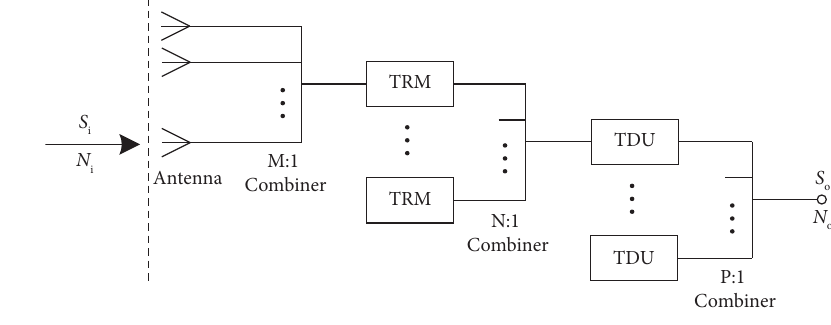
Figure 2: Block diagram of an AESA.